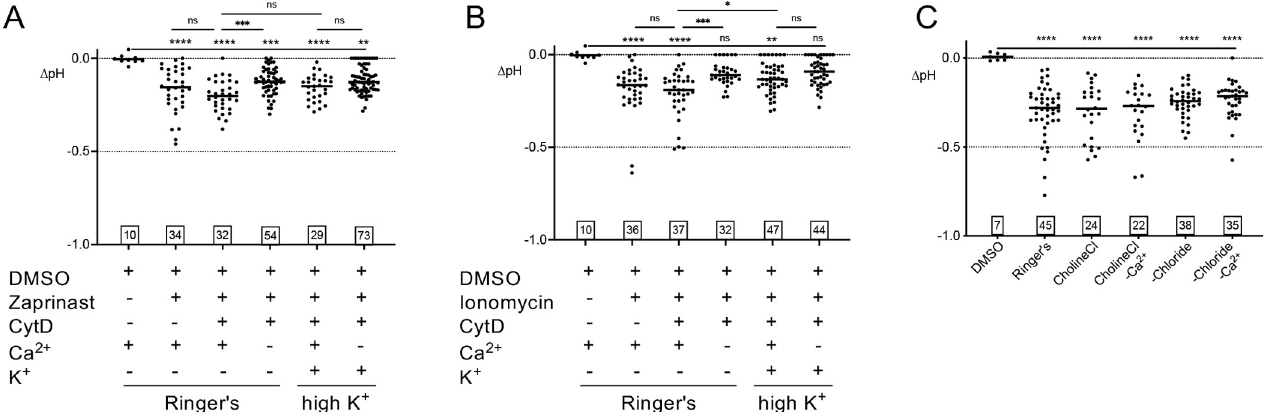
Fig 2. Composition of surrounding buffer mildly abates PV pH changes. A) and B) Extracellular buffer without Ca 2+ tempers the drop in pH with zaprinast (A) or ionomycin (B) induction. RH-RatpH PVs, treated with or without CytD, incubated in Ringer’s buffer or High K + with or without Ca 2+ and induced with DMSO, ionomycin, or zaprinast. ns, not significant. C) Na + and Cl - do not affect pH changes. Extracellular buffer with Na + replaced with choline or all Cl - replaced with glutamate, with or without Ca 2+ . Numbers in squares within all graphs indicate the numbers of vacuoles enumerated. A Kruskal-Wallis test with Dunn’s multiple comparison was performed for all graphs. Bars indicate the median. � p < 0.05, �� p < 0.01, ��� p < 0.001, ���� p < 0.0001.